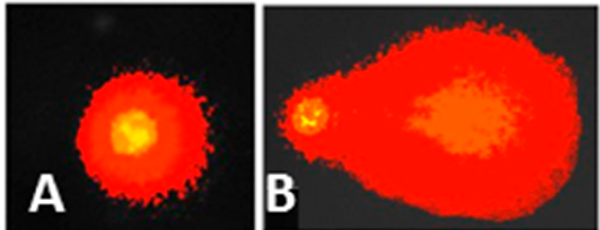
Figure 2. Nuclei without comet (without DNA damage) ( A ) and with comet (with DNA damage) ( B ) from exfoliated buccal mucosa cells.